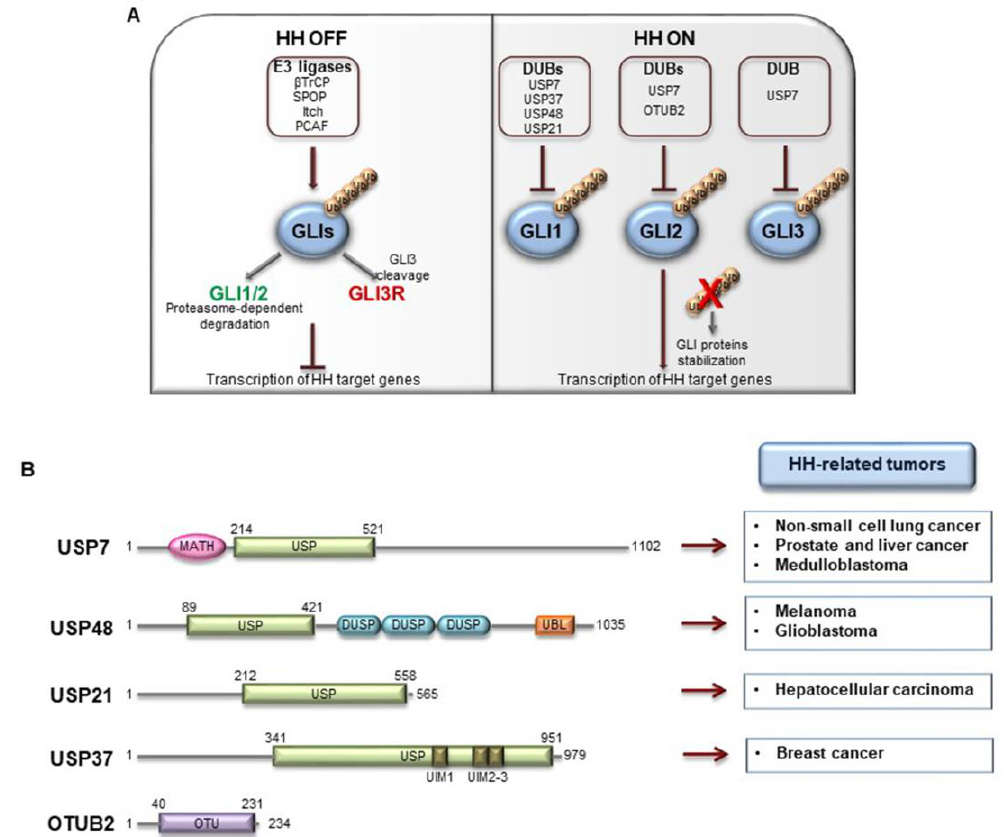
Figure 5. ( A ) E3-ubiquitin ligases and DUBs involved in GLI proteins regulation. In mammals, all GLI factors undergo ubiquitylation processing by di ff erent E3-ubiquitin ligase ( β TrCP, SPOP, Itch, PCAF). When the pathway is OFF, SCF β TrCP E3 ligase promotes the proteasome-dependent degradation of GLI1 and GLI2, and the proteolytic cleavage of GLI3 and to lesser extent GLI2 into the repressor forms. This modification blocks the transcriptional activity of GLIs. Ubiquitylation events are counteracted by the activity of DUBs (USP7, USP37, USP48, USP21, OTUB2) which remove Ub moieties from GLI factors. GLI proteins are then stabilized and can exert their activity promoting the expression of HH target genes. ( B ) Structure of human DUBs acting on GLI proteins. The boxes on the right indicate the main HH-related tumors in which these DUBs are involved. USP: ubiquitin specific protease